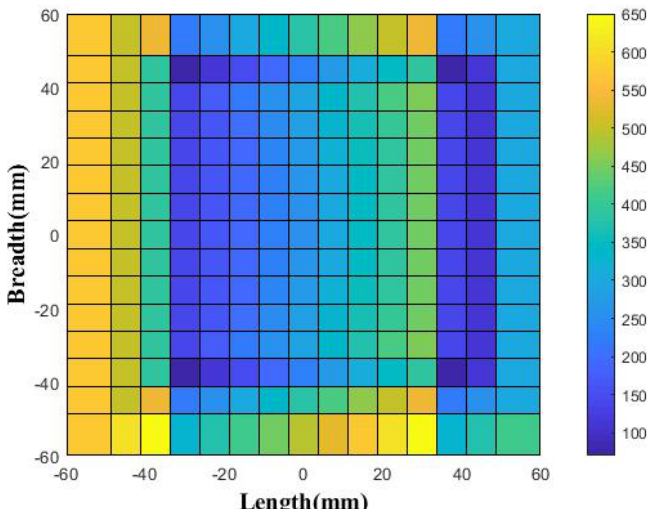
Figure 10. Phase distribution of BDS for the designed four-layer prototype.